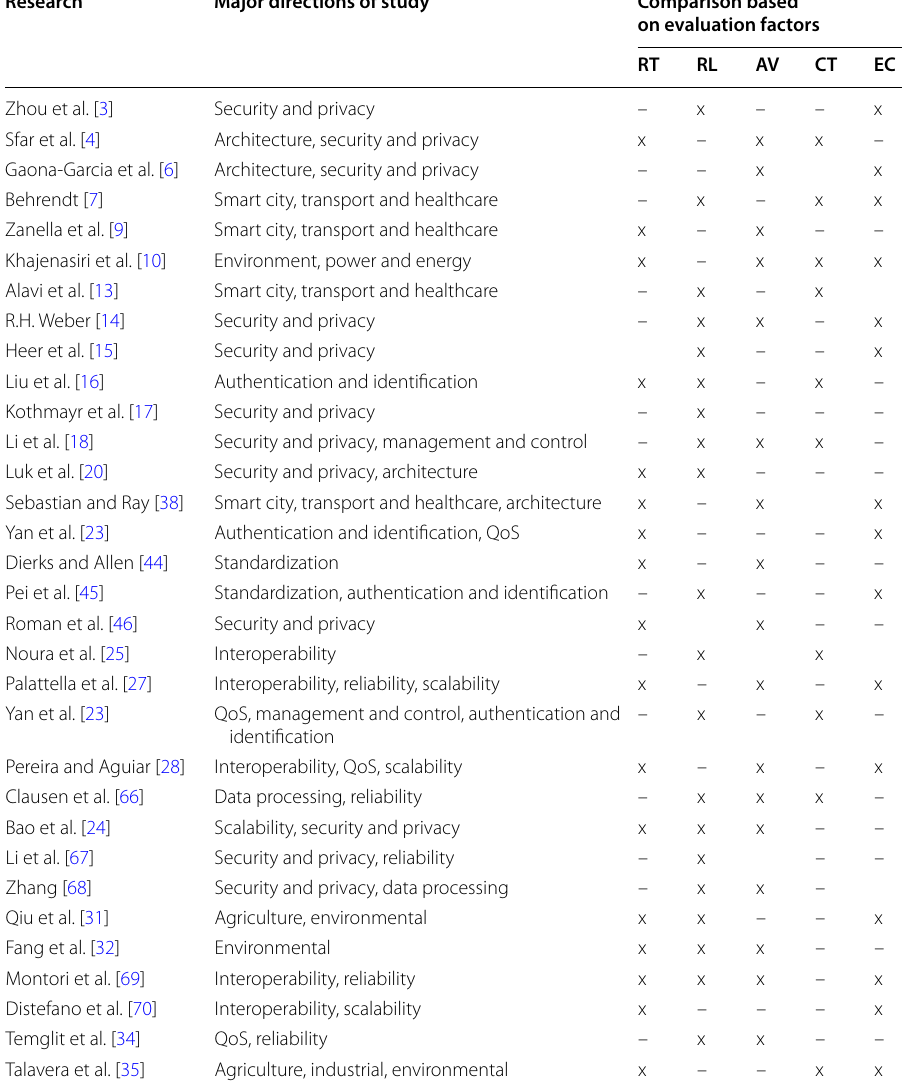
Table 1 Comparative illustration of specific research studies on evaluation